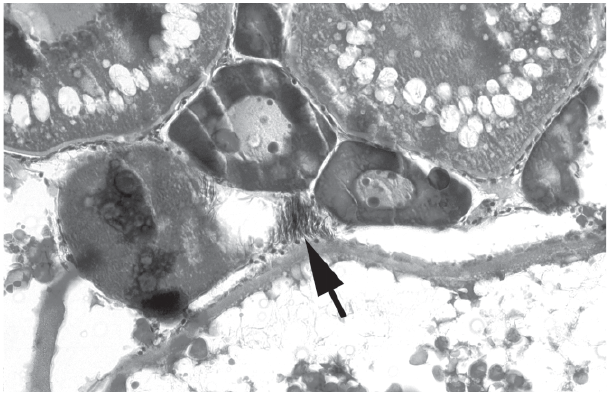
Fig. 7. Lophiobrycon weitzmani , paratype, section through mature female ovary. Arrow indicates spematozoa. LIRP 4338, 25.5 mm SL, same locality data as in Figs. 1 and